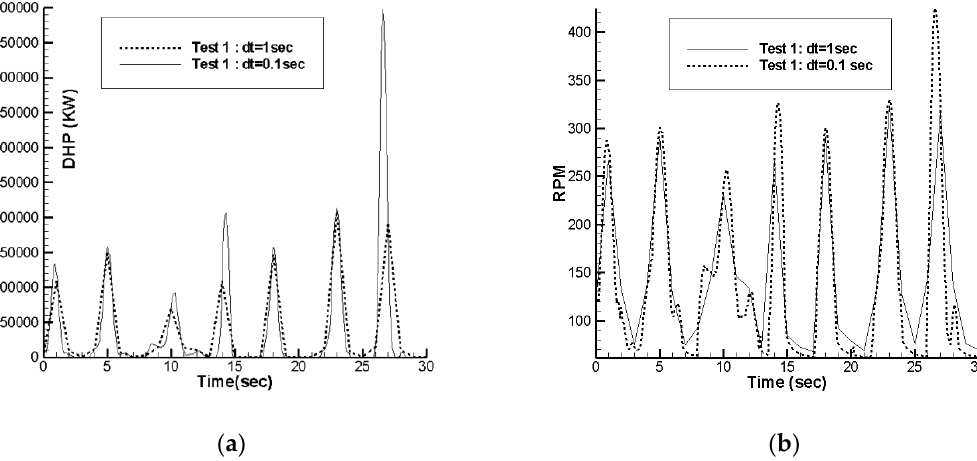
Figure 37. Comparison of the time history of the required DHP ( a ) and RPM ( b ), numerical experiment #1.